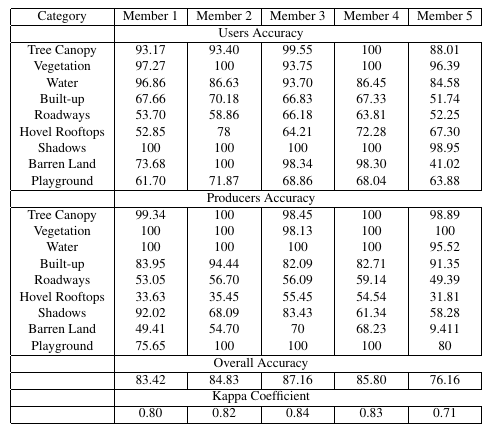
Table 4: Individual member accuracy estimates